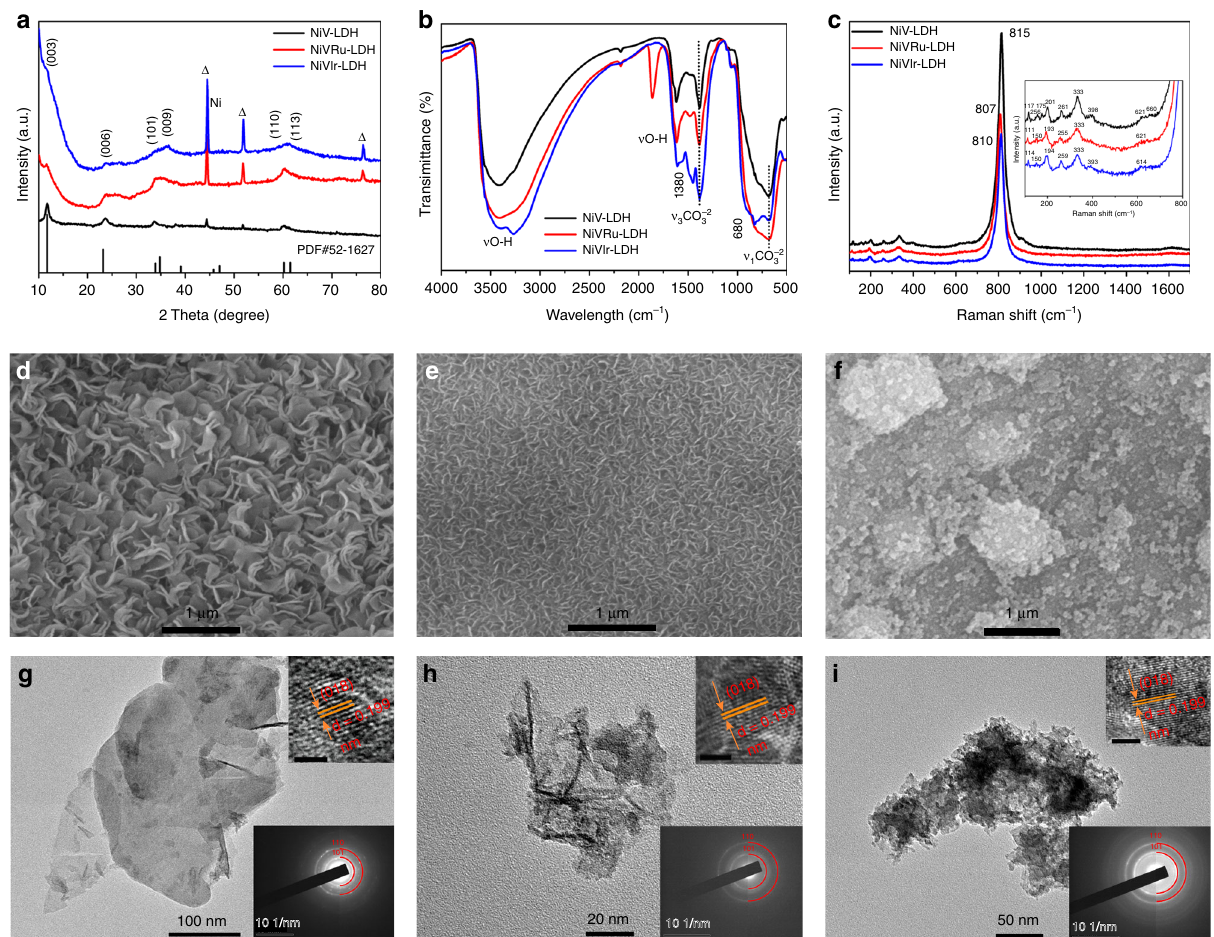
Fig. 1 XRD patterns, FTIR spectra, Raman spectra, SEM, and TEM images. a The XRD patterns of NiV-LDH, NiVRu-LDH, and NiVIr-LDH scraped from Ni foam. b FTIR spectra of the electrocatalysts in vacuum condition. c Raman spectra of NiV-LDH, NiVRu-LDH, and NiVIr-LDH with 532 nm excitation under ambient air. d and g , e and h , f and i are the SEM and TEM images of NiV-LDH, NiVRu-LDH, and NiVIr-LDH, respectively. The upper right insets of g , h , and i are the HRTEM images of NiV-LDH, NiVRu-LDH, and NiVIr-LDH with scale bars of 1 nm, respectively, and the bottom right insets of g , h , and i are the corresponding SAED